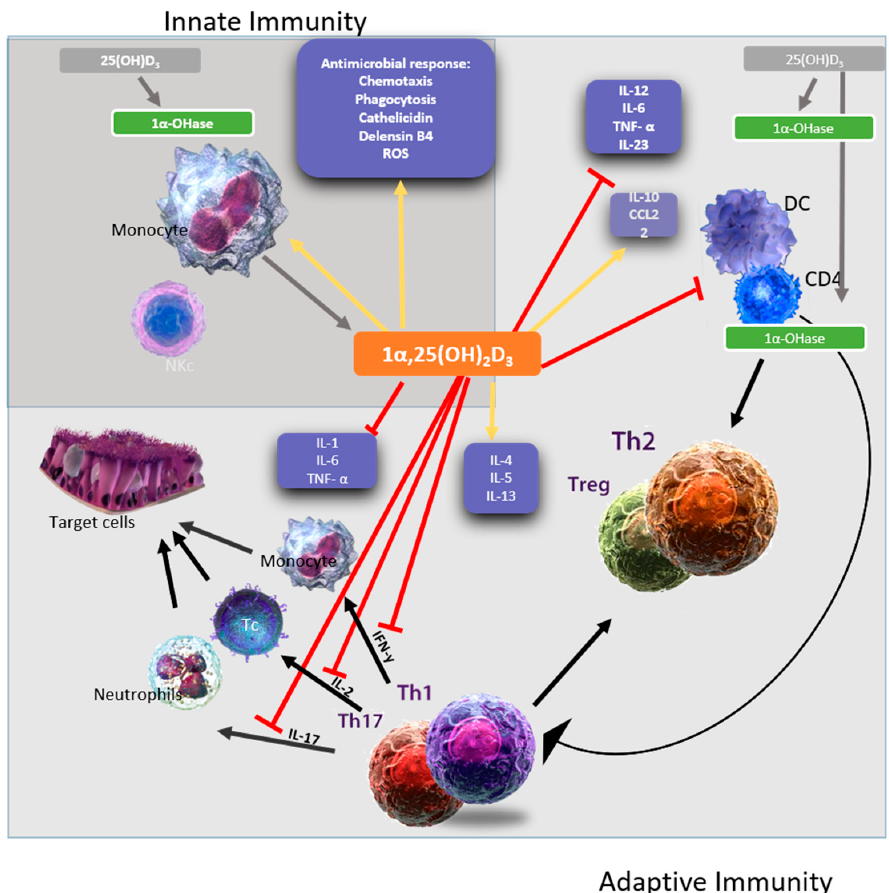
Figure 1. A representative figure of the immunomodulatory effects of 1,25(OH)2D3. 1,25(OH)2D3 targets different players of the innate (dark grey square) and adaptive immune (light grey square) compartment. Vitamin D has been shown to enhance chemotaxis, antimicrobial peptides, and macrophage differentiation to stimulates the innate immune responses. In addition, Vitamin D also stimulates the adaptive immune responses. For example, at the level of the antigen-presenting cells, like dendritic cells, Vitamin D inhibits the surface expression of the MHC-II-complexed antigen, co-stimulatory molecules, and the production of IL-12 and IL-23 cytokines leading to indirectly shifting the polarization of T cells from a Th1 and Th17 phenotype towards a Th2 phenotype. The figure is adapted from [97,98] .